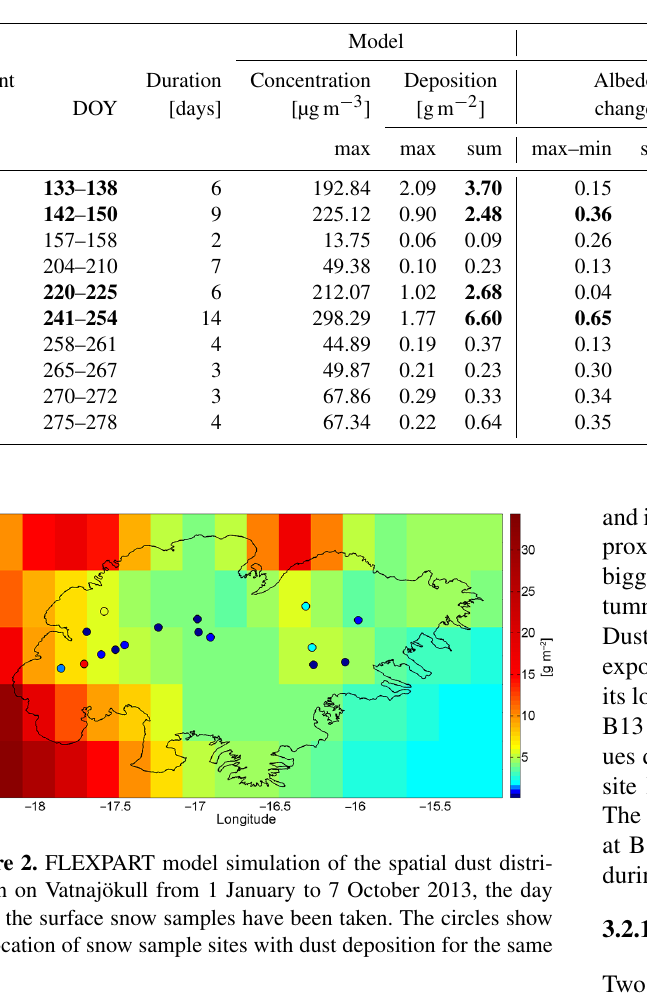
Table 2. Dust events at station B13. The modelled maximum and minimum dust concentration, the maximum simulated daily deposition, the total deposition during the event, the measured albedo change, maximum and minimum temperature and wind direction from the AWSs and the precipitation sum from the ECMWF model are reported.